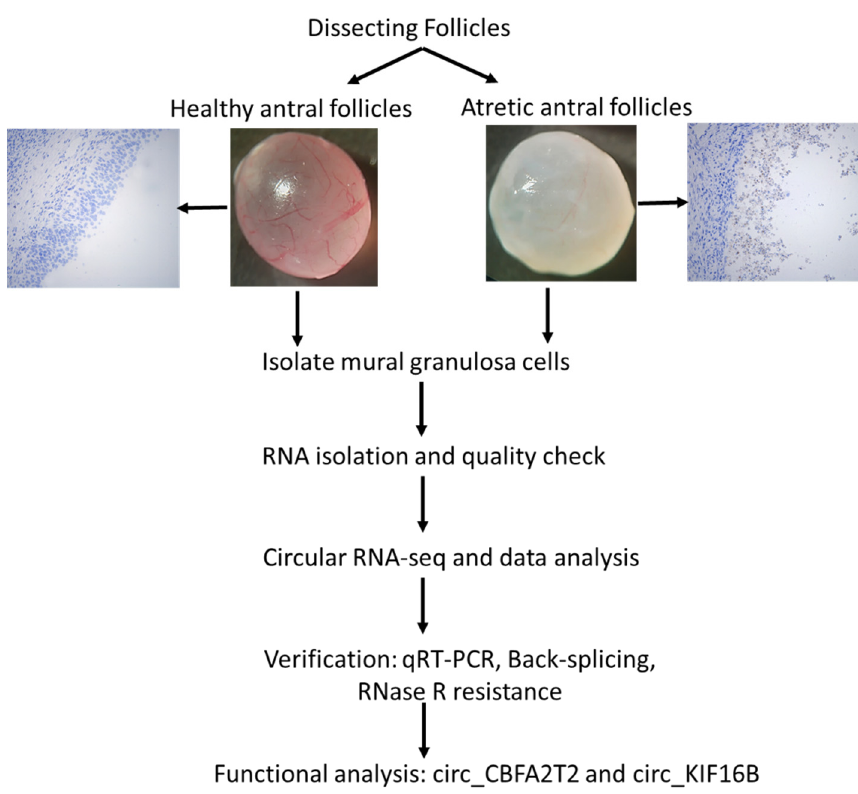
Figure 8. Overview of experimental design.